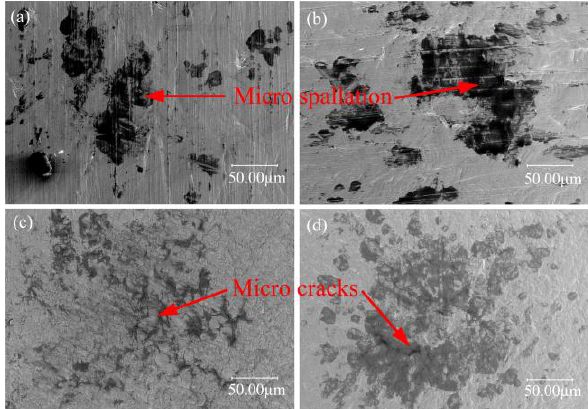
Figure 7. The bottom surface feature of the micro bulging parts under different conditions: ( a ) 60 µm, 565 mJ ( b ) 60 µm, 835 mJ ( c ) 40 µm, 565 mJ ( d ) 40 µm, 835 mJ.